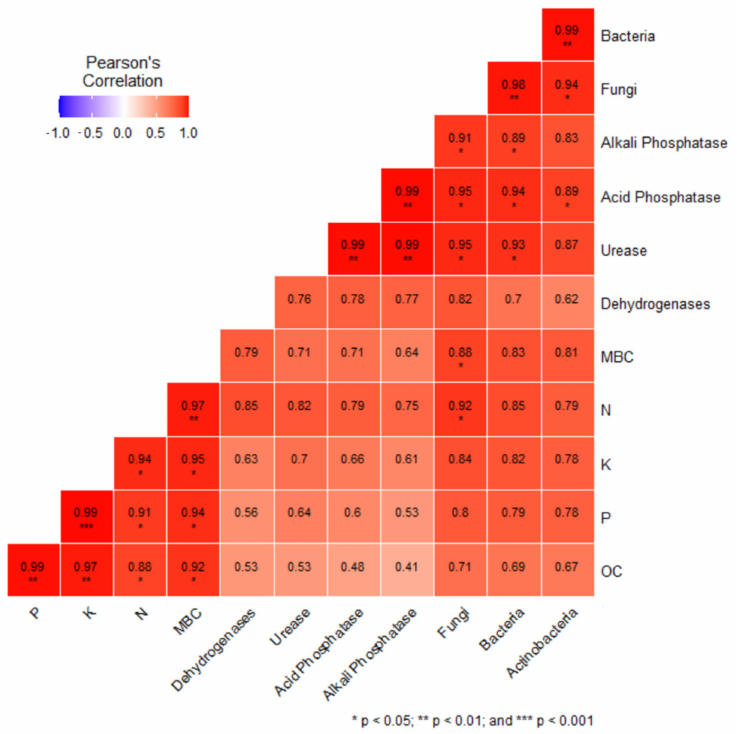
Figure 6. Correlation of soil microbes and enzymes with soil chemical properties; *, ** and *** indicate a significant difference at p < 0.05, p < 0.01 and p < 0.001, respectively. OC—organic carbon (%); MBC—microbial biomass carbon (mg/kg); N—available nitrogen (kg/ha); P—available phosphorus (kg/ha); K—available potassium (kg/ha). Bacteria ( × 10 5 cfu/g); fungi ( × 10 4 cfu/g); actinobacteria ( × 10 4 cfu/g); urease (NH 3 µ g/g/h); dehydrogenases ( µ g TPF formed/g soil/h); acid phosphatases ( µ g PNP/g/h) and alkali phosphatases ( µ g